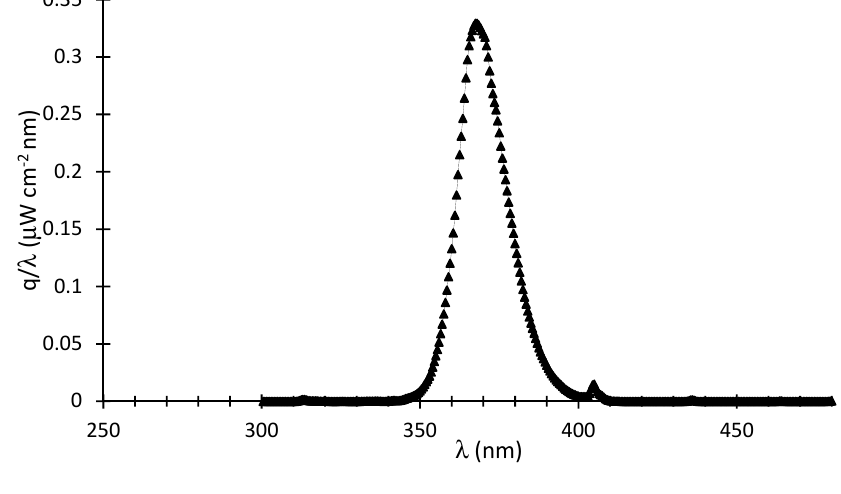
Figure A1. q at various wavelengths.